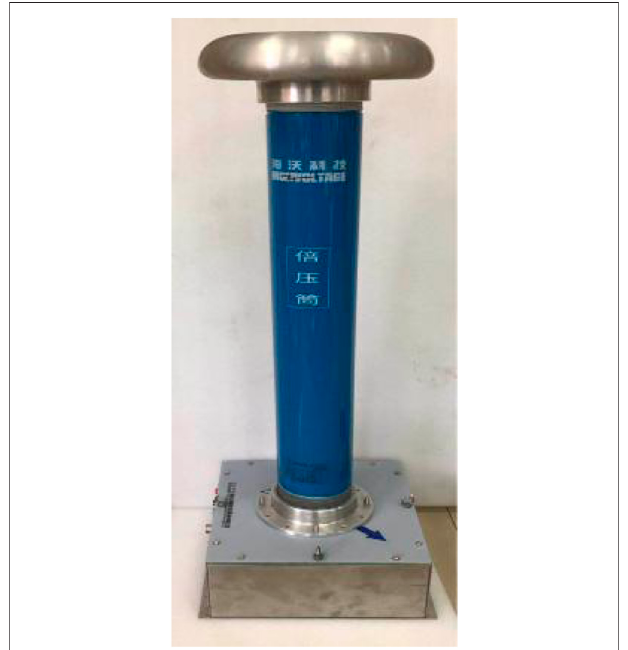
FIGURE 4 | Compressed loop after assembly.